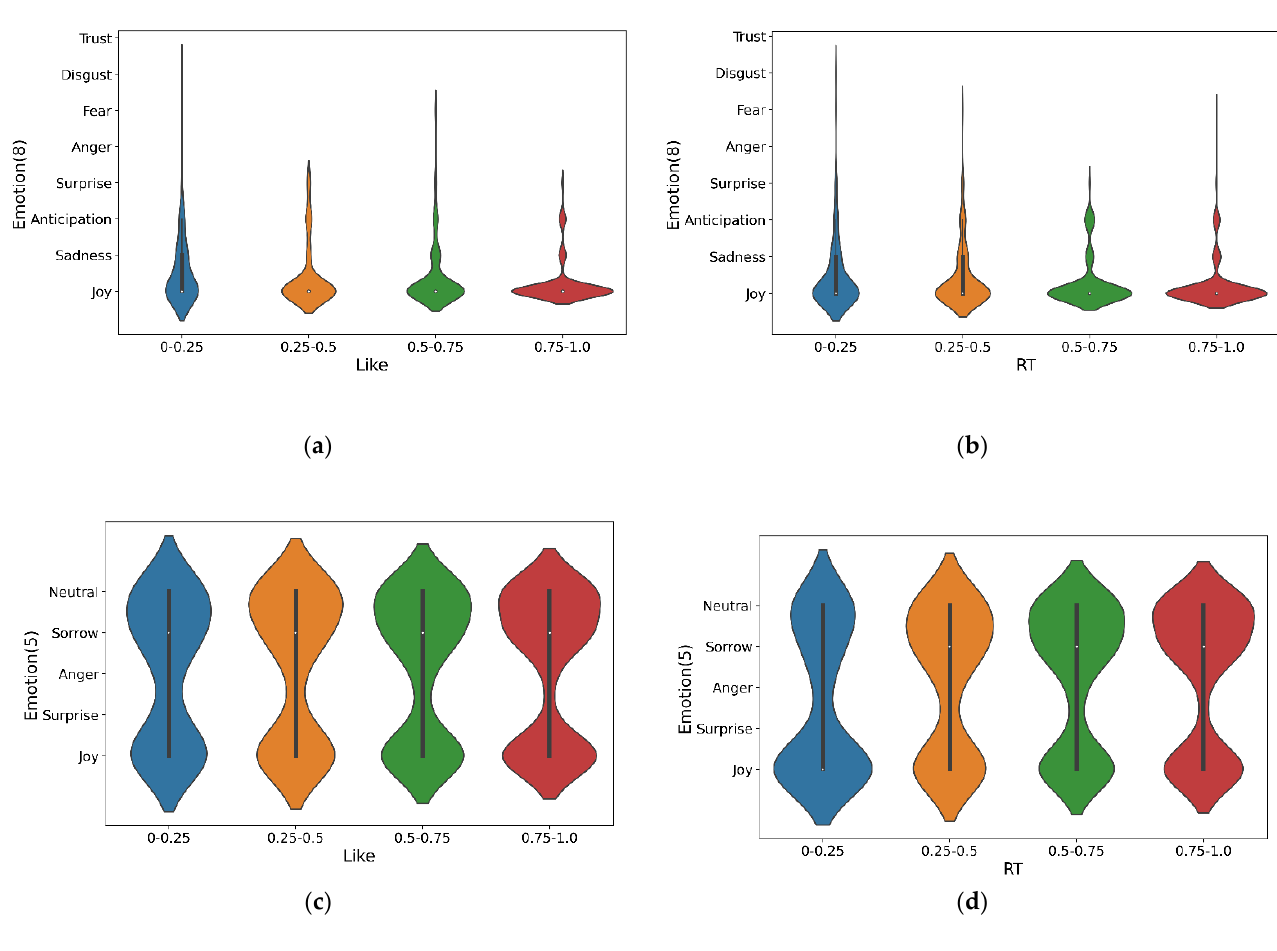
Figure 6. Relationship between RT, like, and tweet and reply emotions; ( a ) eight emotions and likes, ( b ) eight emotions and RTs, ( c ) five emotions and likes, ( d ) five emotions and RTs (the horizontal label indicates the quartile range label of like/RT).